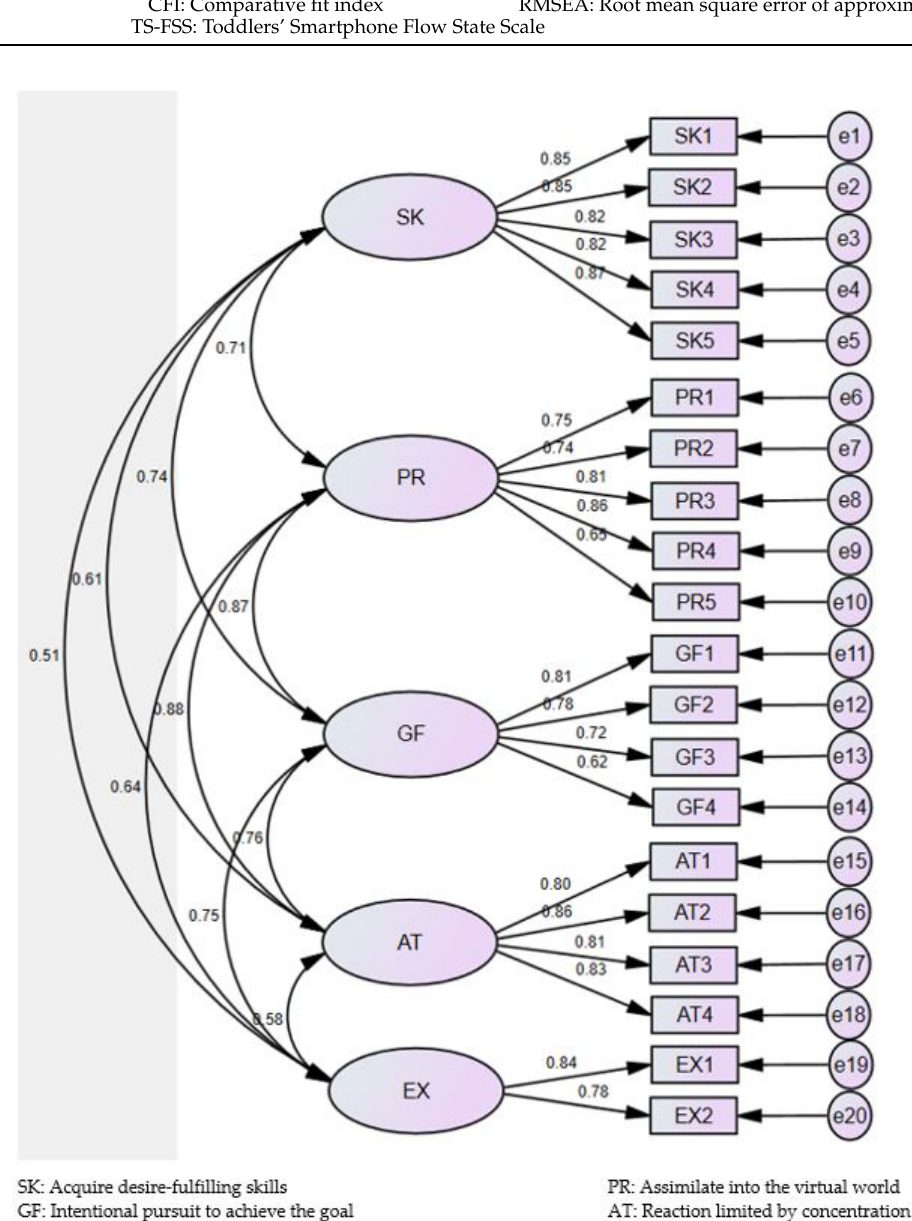
Figure 2. Confirmatory factor analysis model of TS-FSS ( n =